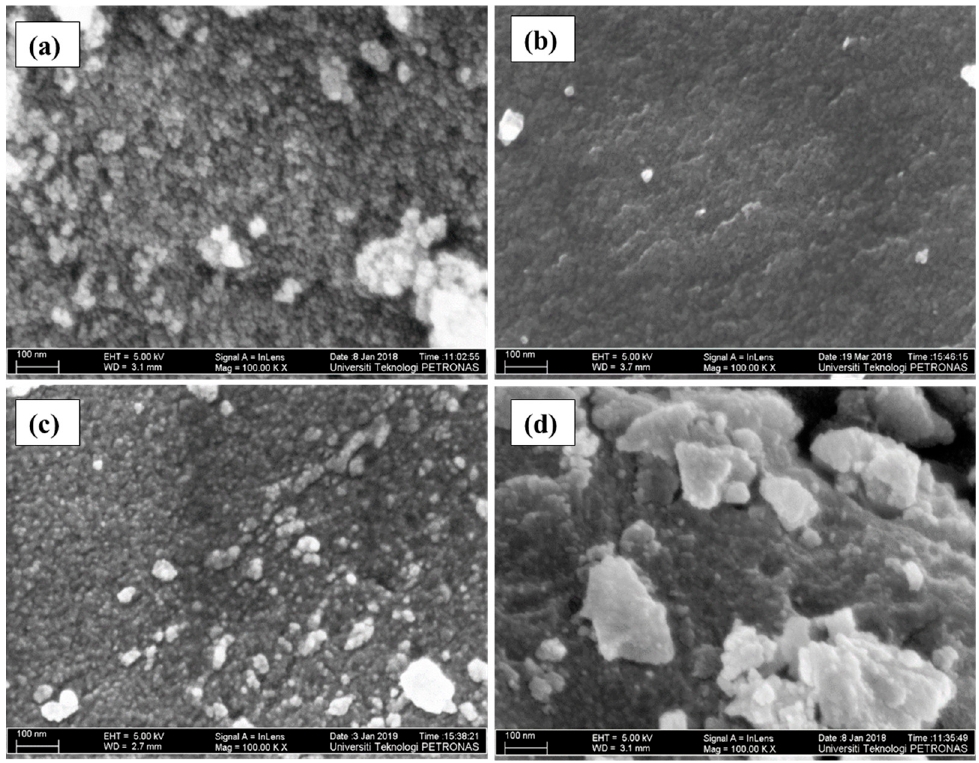
Figure 5. FESEM photographs of the colored TiO 2 prepared at various glycerol concentrations and calcined at 300 °C; ( a ) T1, ( b ) T2, ( c ) T3, and ( d ) T4.